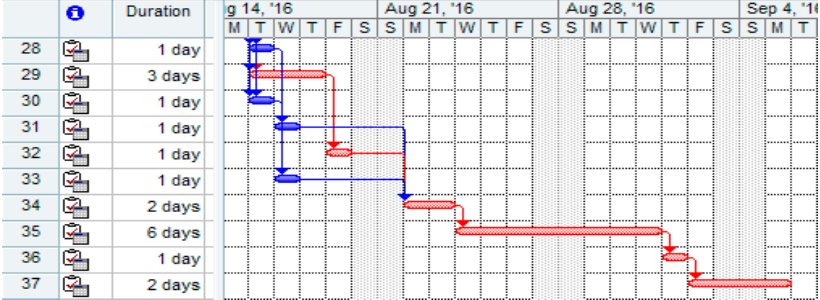
Figure 9. Illustrative part of gantographic display of the initial phase of the project to improve the environmental protection system in mining and energy complexes.